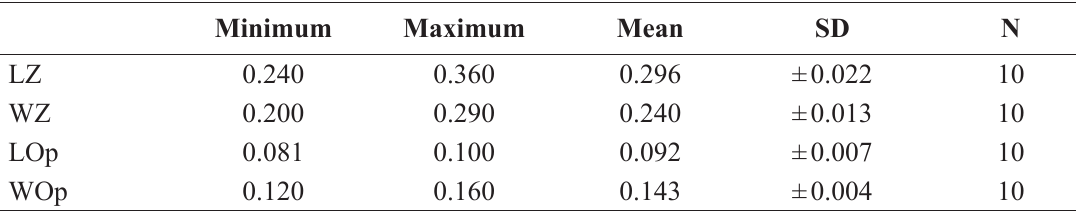
Table 4. Measurements in mm of Antropora Gadhavii Guha & Gopikrishna, 2005 (GIS/B 0461 to 0470), Aquitanian, lower Miocene, Kharinadi Formation, western Kachchh, Gujarat, India. Abbreviations: see Material and methods.